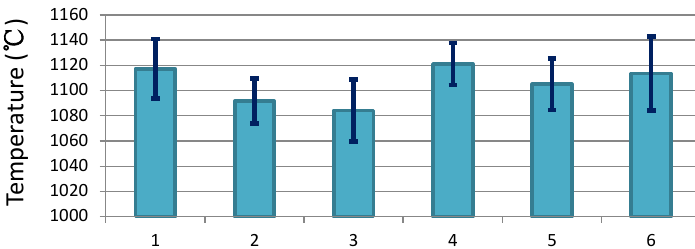
Figure 1. Standard deviation of the temperature sampling error of different steel grades from the rough mill: (1) general structural steel; (2) hull structural steel; (3) high strength low alloy steel; (4) container sheet; (5) carbon structural steel; (6) hot-rolled alloy steel coil. Data were provided by LiuSteel in